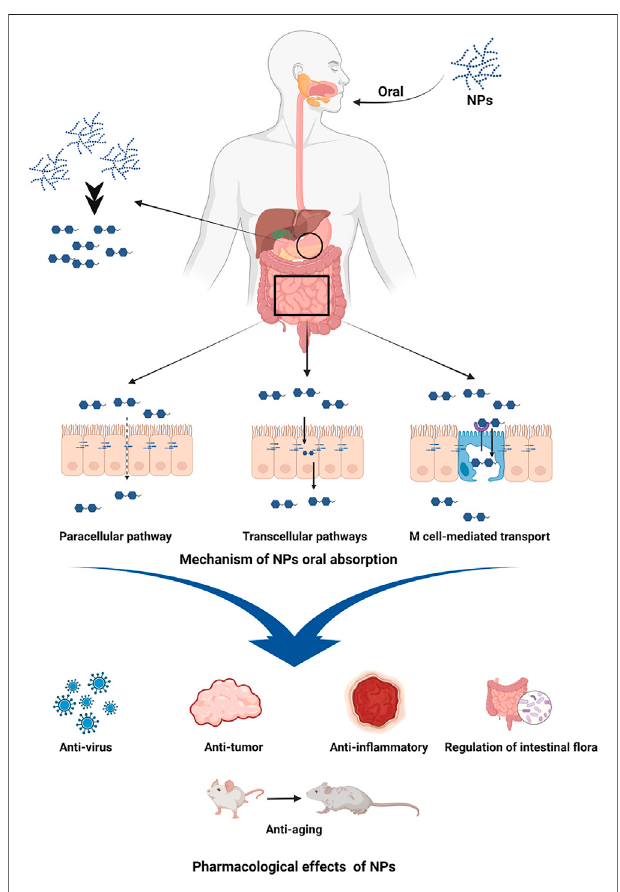
FIGURE 1 | Oral absorption mechanism and pharmacological effects of NPs. Image was made in BioRender (biorender.com).